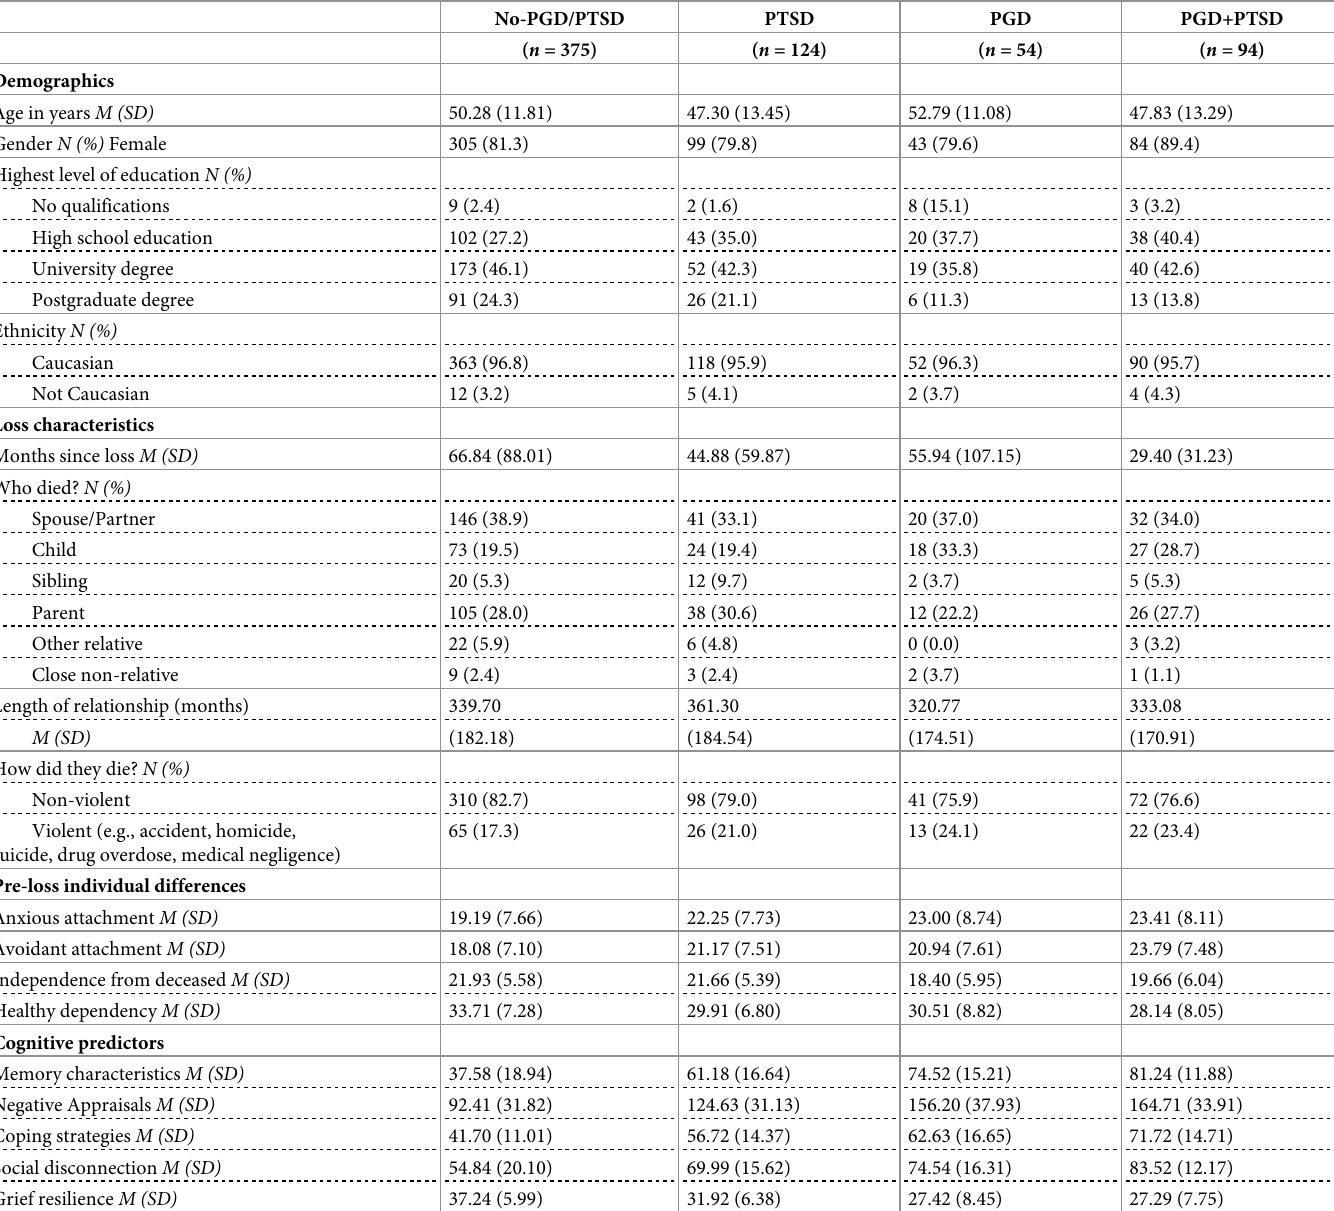
Table 1. Group demographics, loss characteristics and previously established predictor variables for PGD, PTSD, PGD+PTSD,